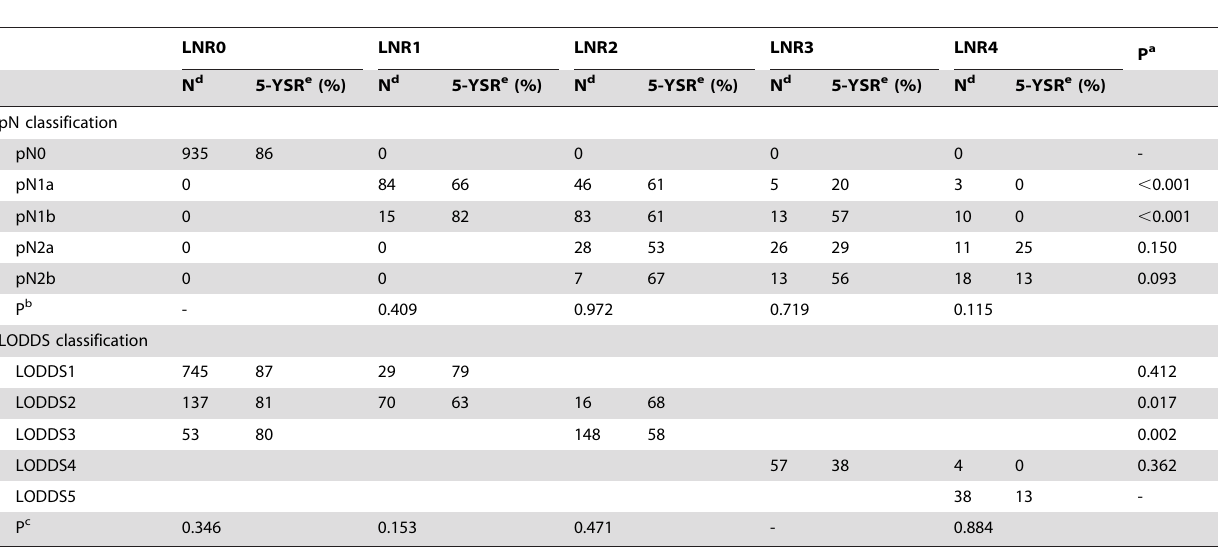
P a : Comparison of survival rates between different LNR groups. P b : Comparison of survival rates between different pN groups. P c : Comparison of survival rates between different LODDS groups. N d : Number of patients. 5-YSR e : 5-year accumulative survival rate. doi:10.1371/journal.pone.0028937.t003 PLoS ONE |